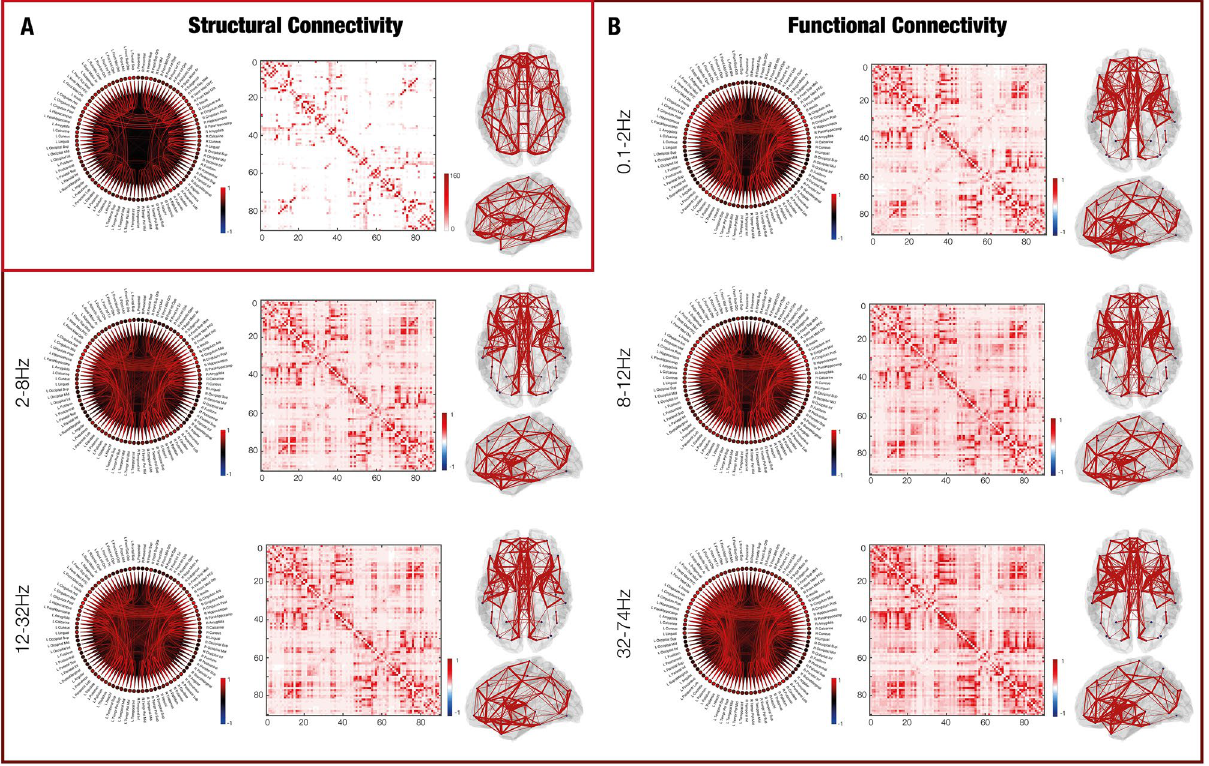
Figure 2. Structural and functional whole-brain connectivity. ( A ) Structural connectivity computed from DTI data. The circular connectogram and the connectivity matrix represent the connections between the 90 AAL nodes. The different connection strengths are represented by different colour shades. The whole-brain figures depict the whole-brain connections, with stronger connections being thicker. Colourbars indicate the normalized average number of streamlines connecting the brain areas. ( B ) Similarly, functional connectivity computed from MEG data, for each of the five frequency bands analysed. Colourbars indicate the Pearson’s correlations, showing the functional connectivity between brain